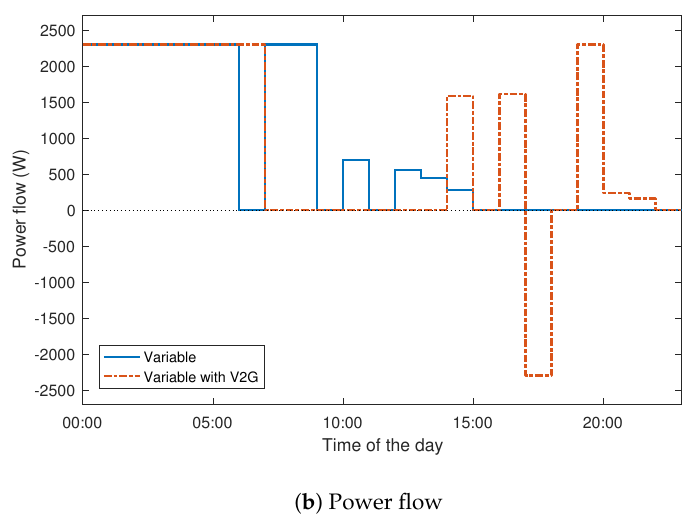
Figure 11. Charge schedule with and without V2G for utility